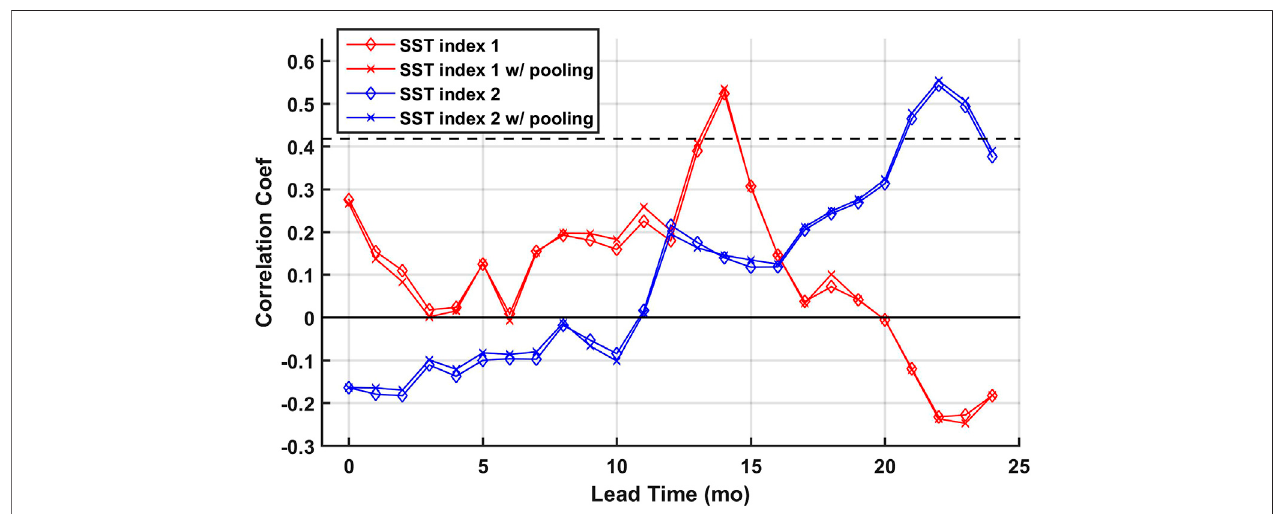
FIGURE 12 | Lagged correlations between the TRHR precipitation and the SST indices. The p -value (cid:1) 0.01 signi fi cance level is plotted in the black dashed line.